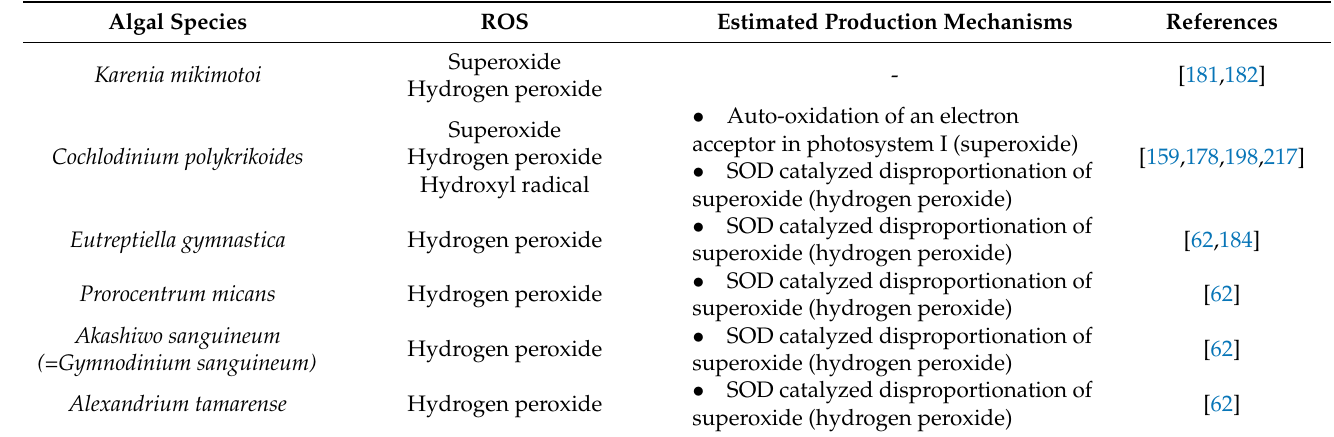
Table 3. Reactive oxygen species (ROS)-producing microalgae and the estimated production